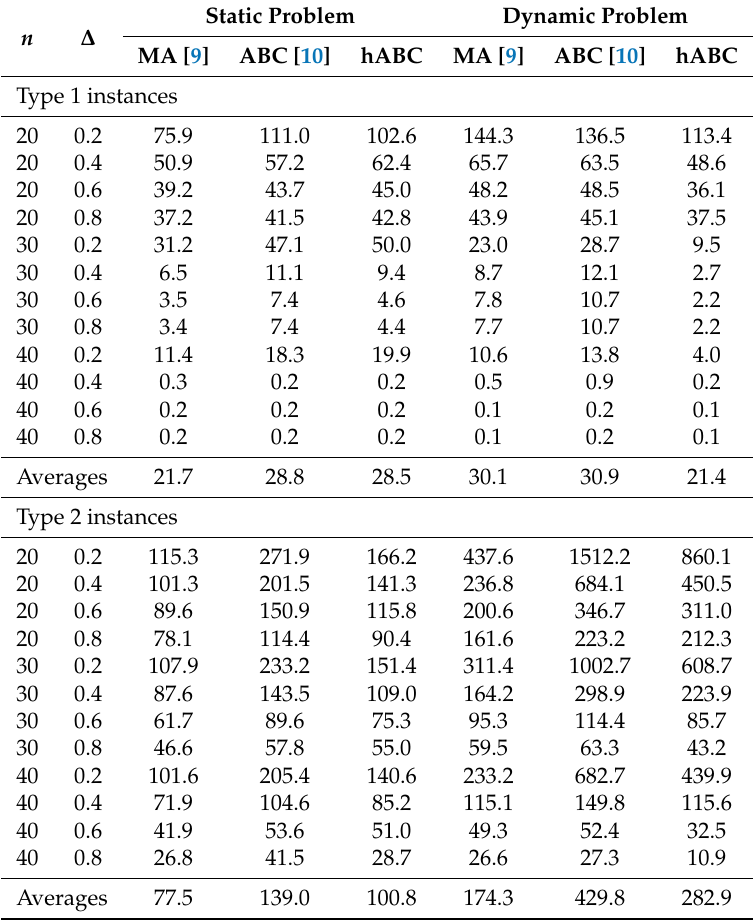
Table 5. Comparison of average execution times (in seconds) with the state of the art in scenario 1 instances. The values of the dynamic problem represent the total execution time for solving all instances (up to 720 in the 24-h